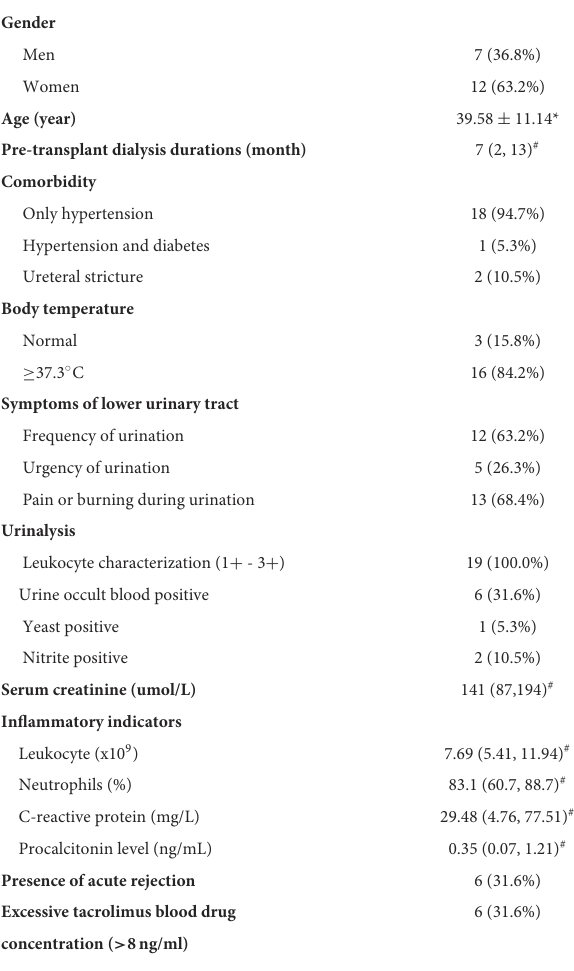
TABLE 1 Baseline characteristics of